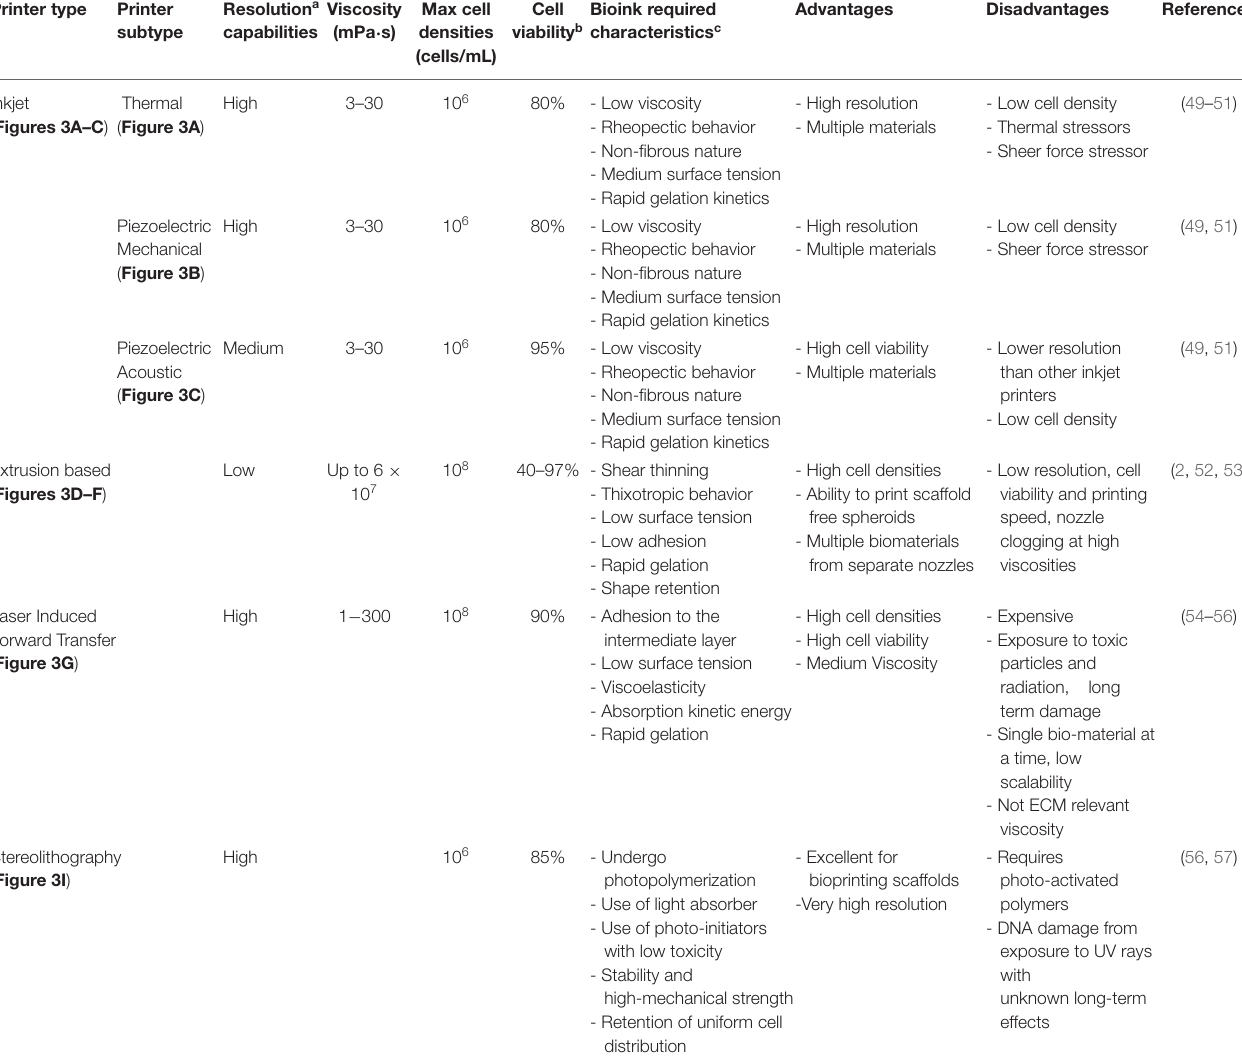
TABLE 2 | Specification of different classifications of bioprinters, their advantages, disadvantages, and required bioink